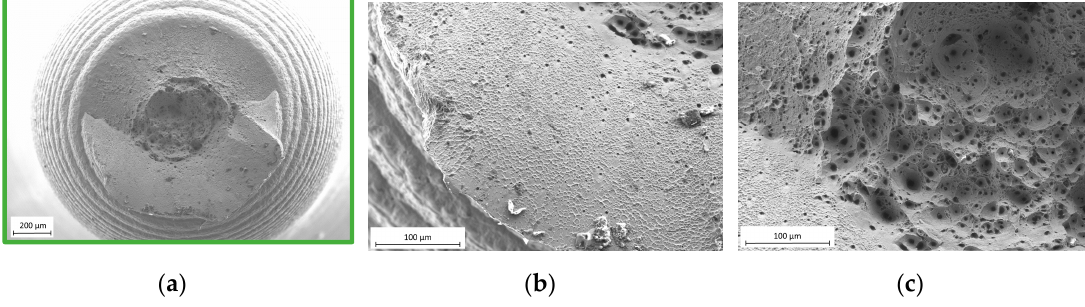
Figure 10. Fracture surface of the SSRT in 43 wt.% CaCl 2 at 120 °C: ( a ) no visible Cl - SCC at the fracture surface, ( b ) ductile structure at the edge of the sample, ( c ) dimple structure at the centre of the sample without visible cracks.